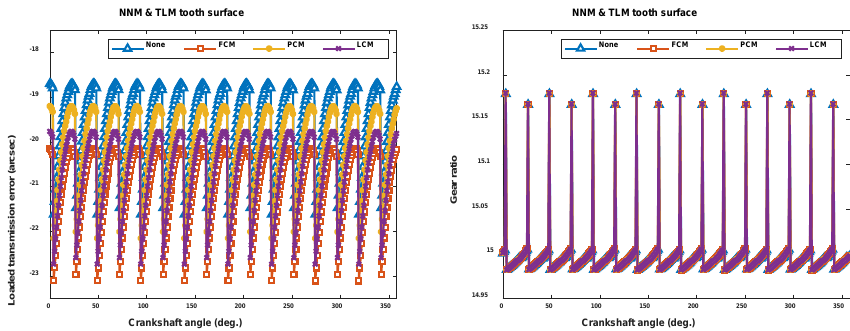
Figure 12. The loaded transmission error and gear ratio of the NNM cycloid gear pair for four cases of TLM in a mesh circle.